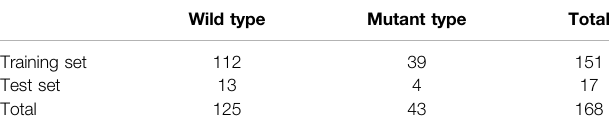
TABLE 1 | Number of each phenotype in the dataset before the